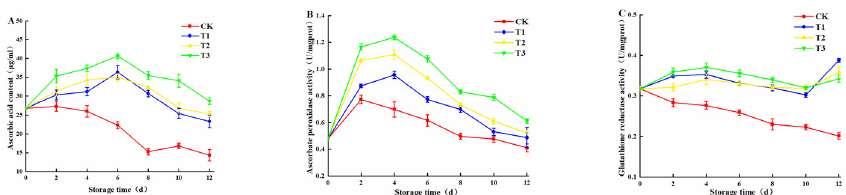
Figure 7. Effects of blue LED 460nm light with different intensities on AsA content ( A ); APX activity ( B ); and GR activity ( C ) of freshly cut amaranth.